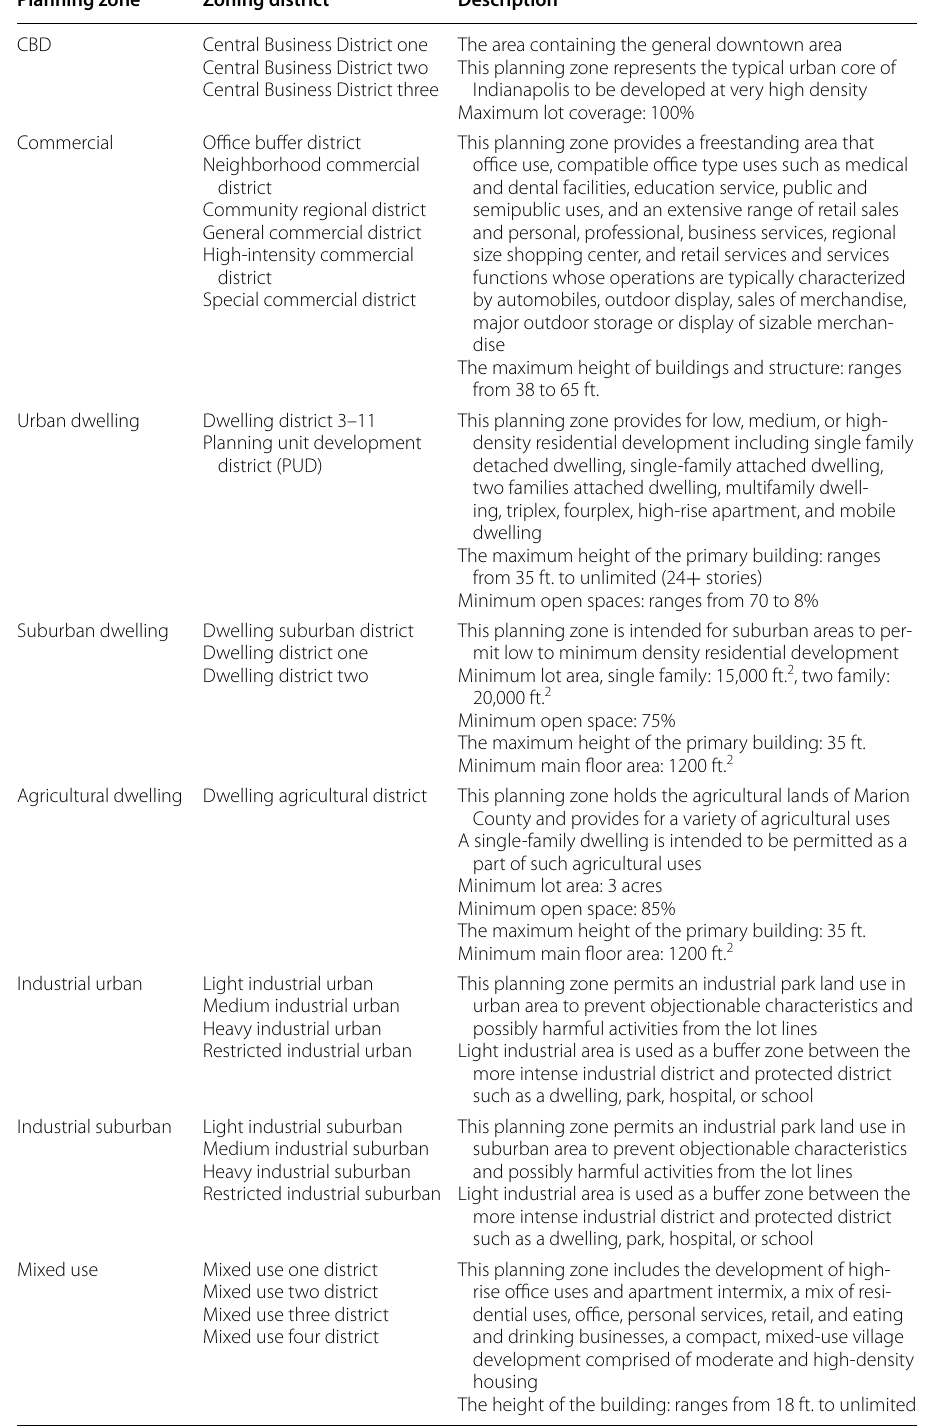
Table 2 Summary of planning zones in Marion County, Indiana Planning